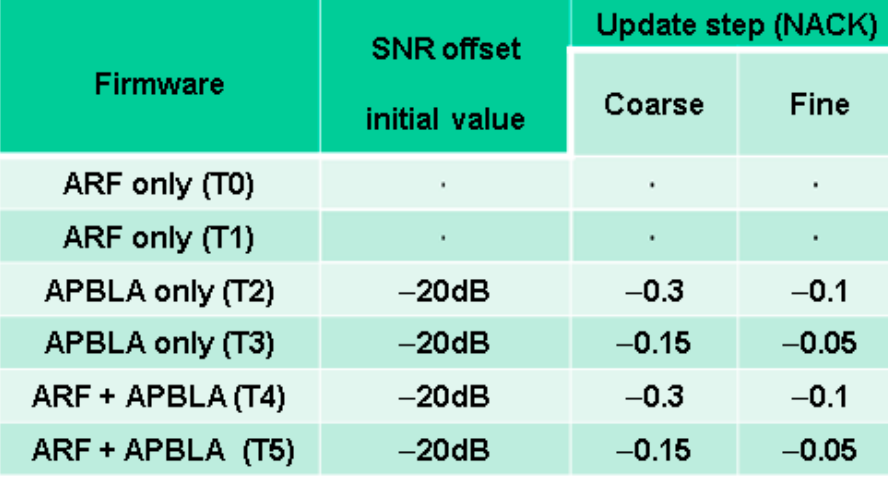
Figure 22. Firmware and parameters used for the wireless tests.